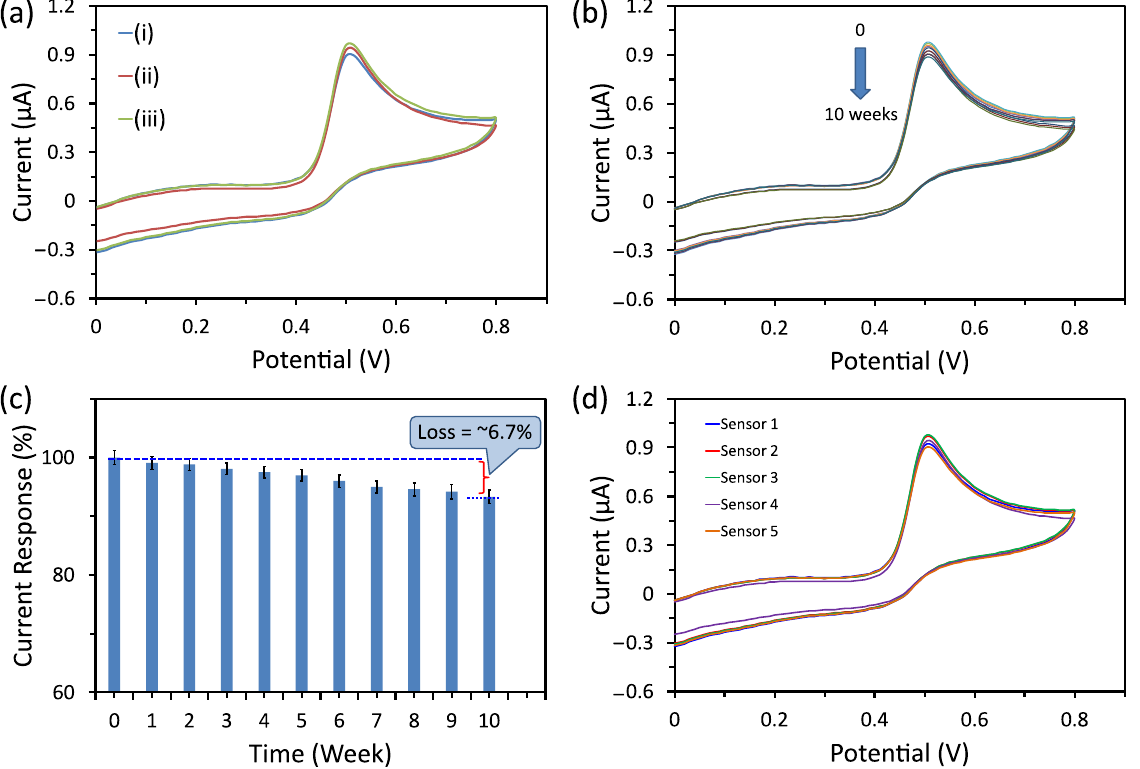
Figure 7. ( a ) CV scans of cobalt oxide puffy balls/GC sensor in PBS buffer containing (i) 50 µ M UA only, (ii) 50 µ M UA and 50 µ M of each possible interfering species (i.e., urea, sodium chloride, fructose, glucose, potassium chloride, L-cysteine, and lactic acid), and (iii) 50 µ M UA and 100 µ M of each above-interfering species. ( b ) Sensing response of cobalt oxide puffy balls/GC sensor towards 50 µ M UA for 10 weeks storage time. ( c ) Calibrated response of the sensor showing ~6.7% decrease compared to the sensor fabricated on day 1. ( d ) CV scans of five similar fabricated cobalt oxide puffy balls/GC sensors in PBS buffer containing 50 µ M